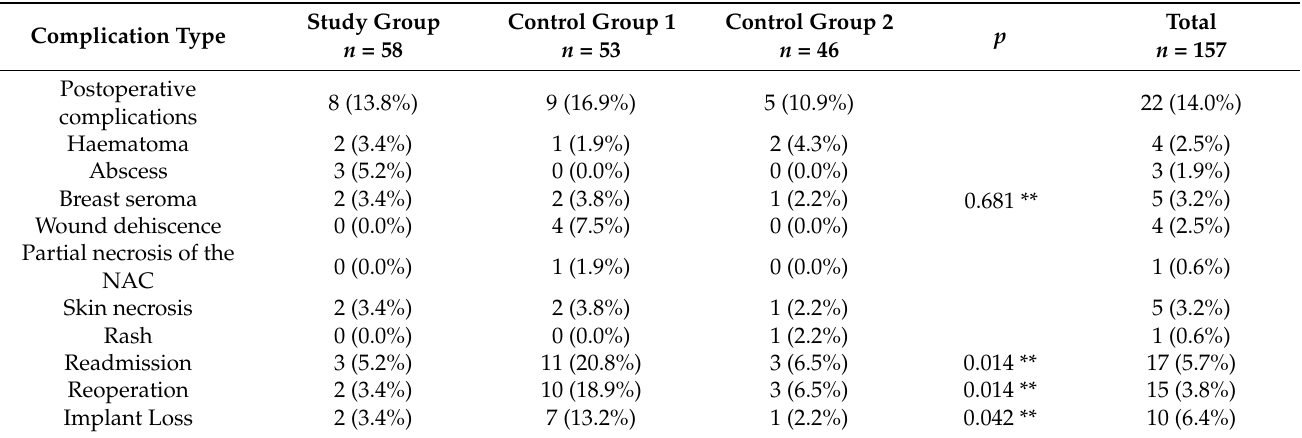
Table 3. Postoperative